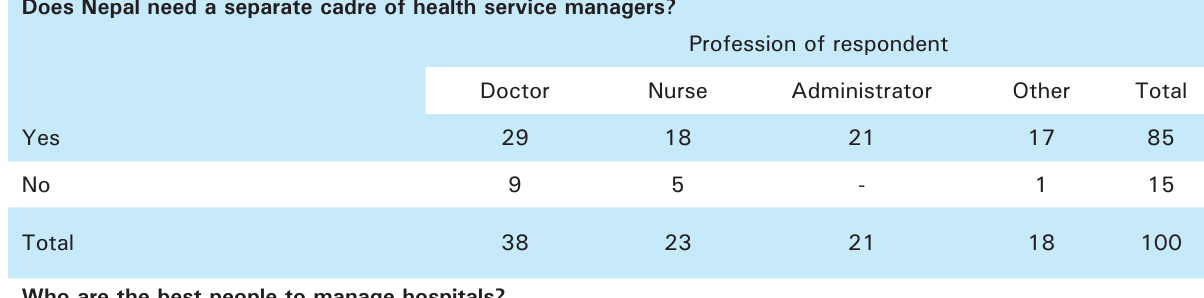
Table 6. Views about health service managers by